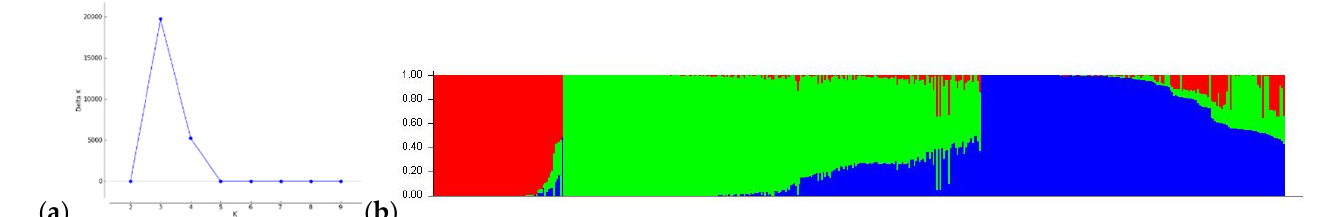
Figure 7. Population structure analysis of the Sesbania sesban collection: ( a ) the delta K showing the highest peak at K = 3 suggesting the presence of three subpopulations and ( b ) a bar plot based on the admixture model in STRUCTURE for K = 3. Passport data shows that 161 accessions in the collection were obtained from 25 coun- tries. Of these, coordinate (latitude and longitude) information is available for 136 ac- cessions. The coordinate information was converted to geographical distances using the distm() function of the R package geosphere [17] and was then used for Mantel correlation